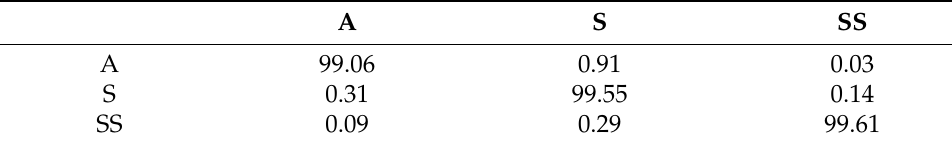
Table 11. The accuracy of the prediction with the Random Forest model.